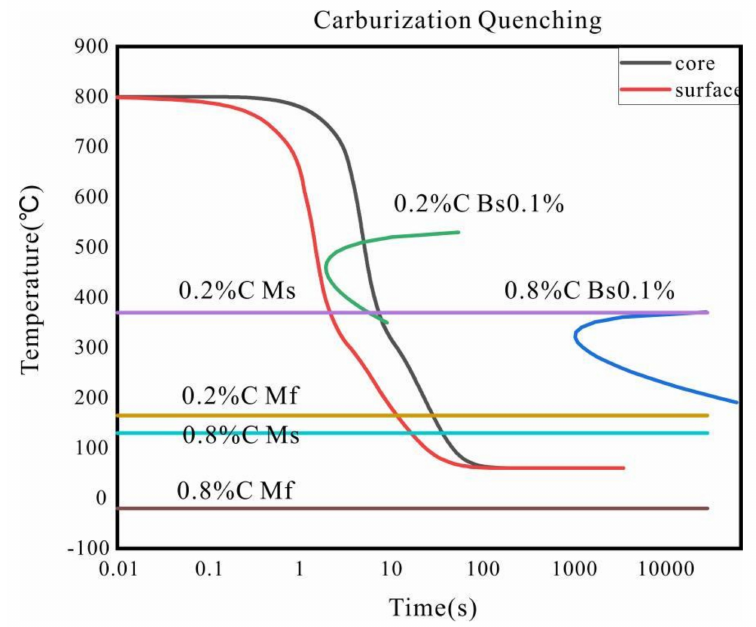
Figure 13. Schematic diagram of the cooling phase transformation process of the surface and core of the carburized